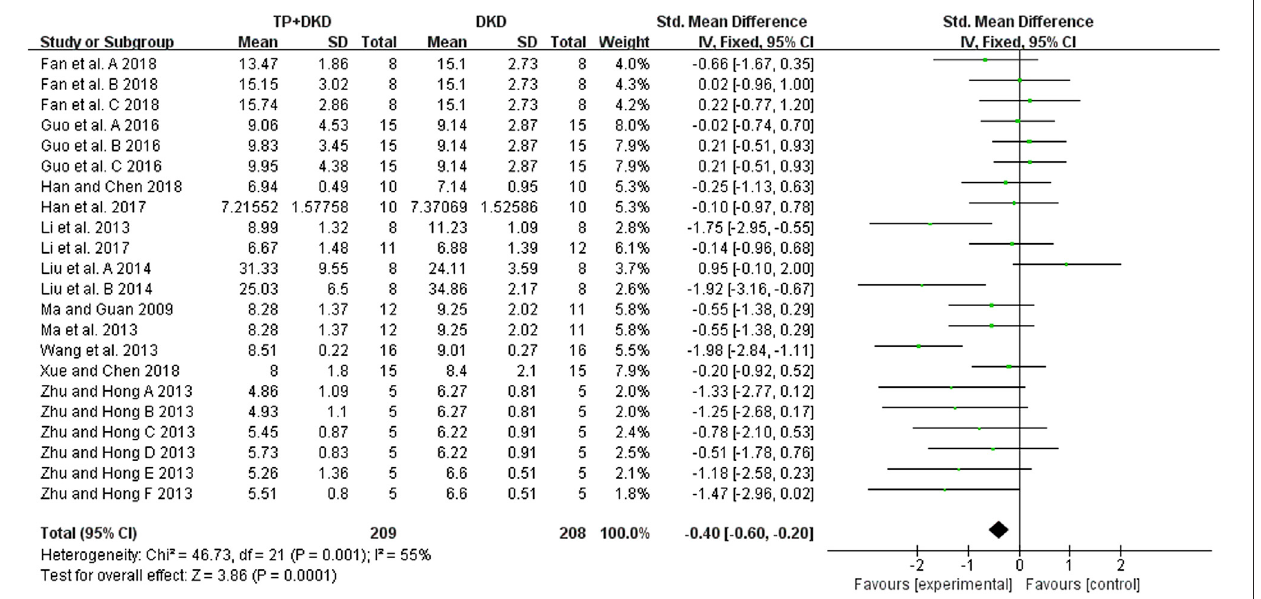
Frontiers in Pharmacology |